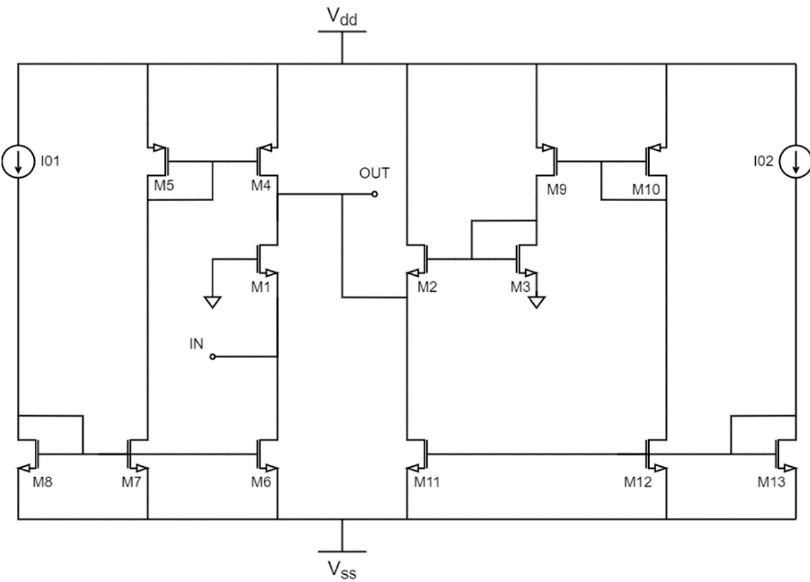
Figure 2. CMOS LNA based on current conveyors with current mirrors as current sources.